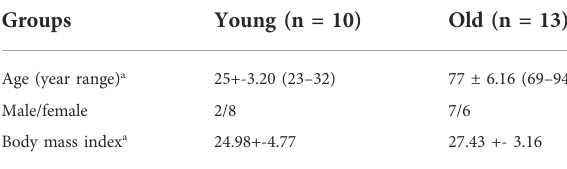
TABLE 1 Subjects characteristics.